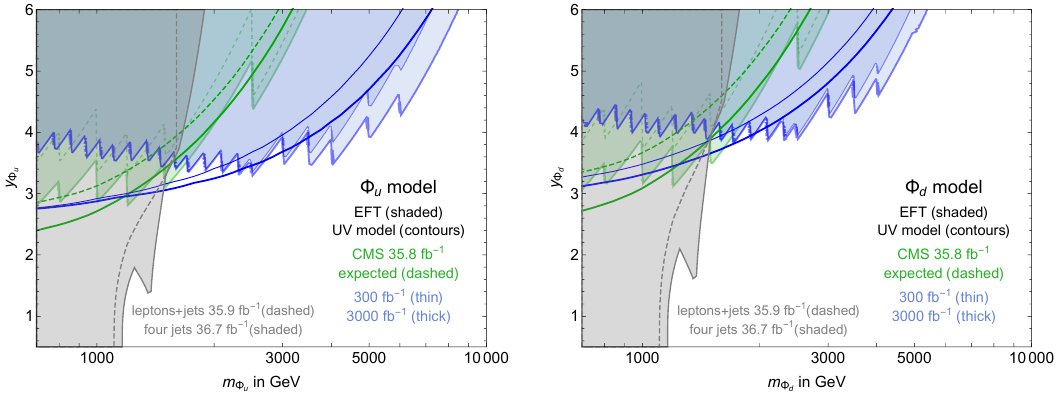
Figure 5 . Left : constraints on the mass and coupling of a color octet electroweak doublet with hypercharge Y = (cid:0) 1 = 2, transforming as a doublet under the U(2) u (cid:13)avor group acting on the (cid:12)rst two generation right-handed up quarks, see eq. (4.4). Right : constraints on a color octet electroweak doublet with hypercharge Y = 1 = 2, this time coupling to the (cid:12)rst two generation right-handed down quarks with a U(2) d invariant coupling. We show 95% CL constraints from CMS measurements of the t (cid:22) t invariant mass distribution [43] and high luminosity projections. Shaded regions show the constraints extracted from the low energy EFT description as in eq. (4.5), while solid contours show the bounds obtained by calculating the corrections to the t (cid:22) t di(cid:11)erential cross section using the full model. Expected CMS exclusions are also displayed (green dashed contours). The dashed gray contours show the bounds on direct pair production of (cid:8) u;d followed by decay to top plus jet [91], while the shaded gray regions show the bounds on pair production of (cid:8) u;d followed by decay to bottom plus jet